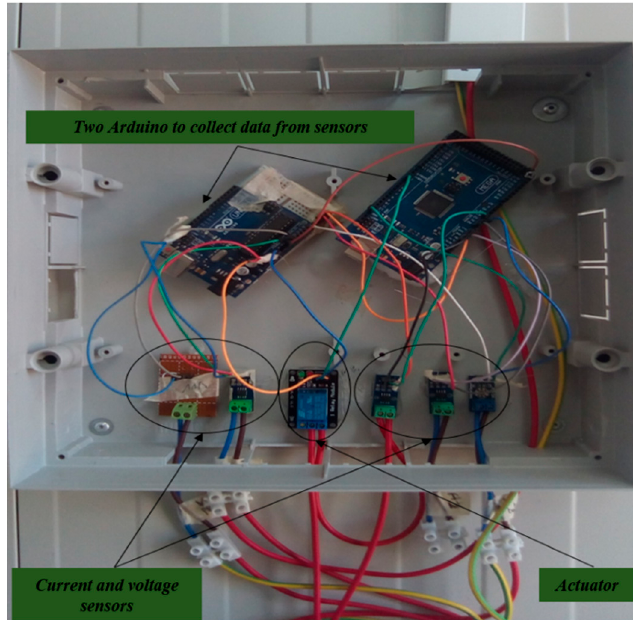
Figure 3. Deployed platform for sensing and actuating.